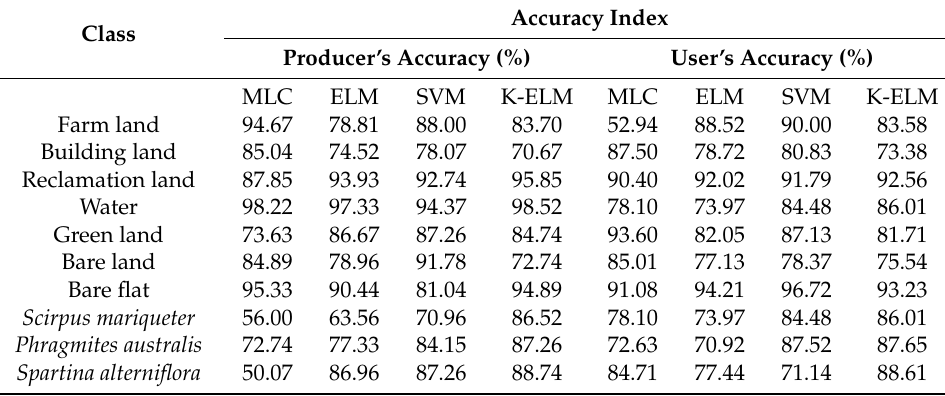
Table 2. Producer’s and user’s accuracy of the four methods.